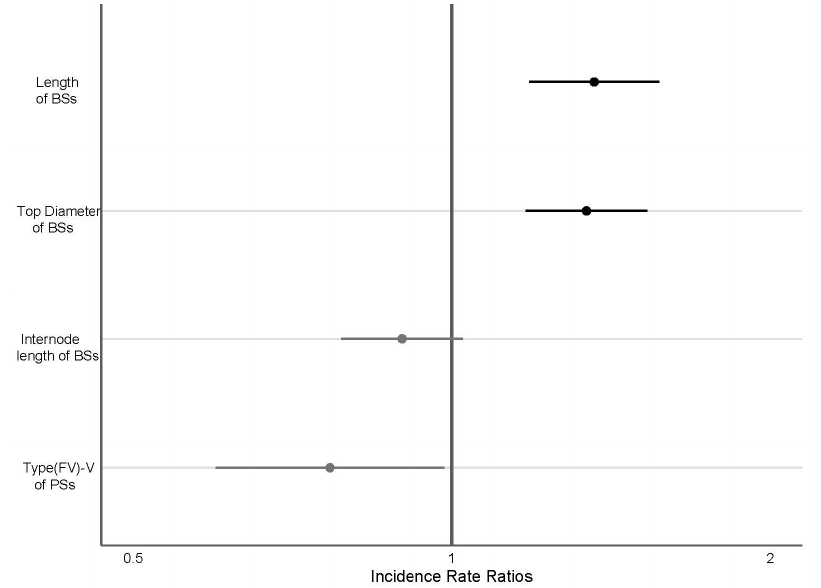
Table 3. Generalized linear mixed model of the total yield of the bearing shoots (BS).